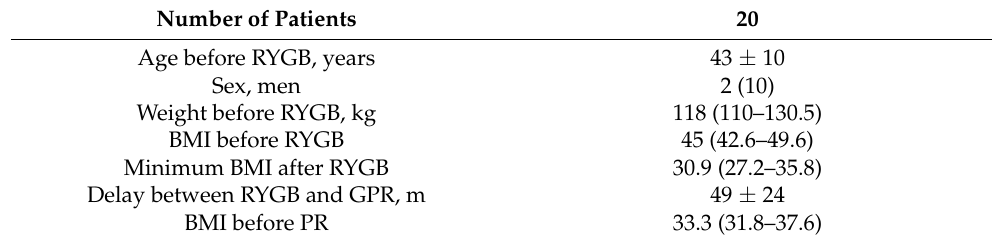
Table 1. Patients’ characteristics at baseline.